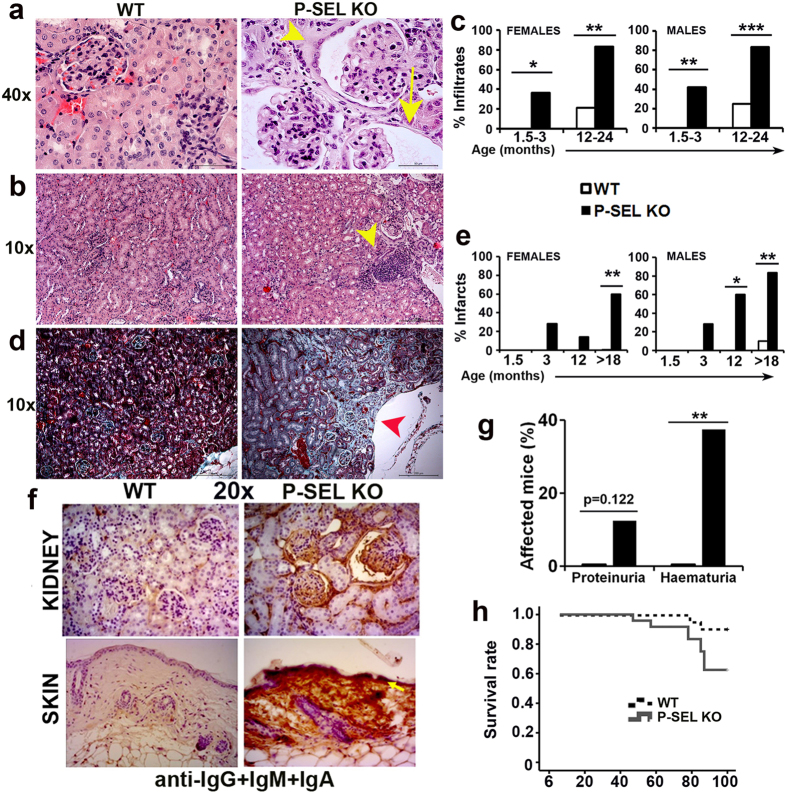
Kidney alterations and deposits of immune complexes in skin and kidneys of P-Sel−/− mice.(a) Representative photomicrographs (40×) of H&E-stained kidney glomeruli of WT and P-Sel−/− mice. Yellow arrow denotes a dilated Bowman’s space. Yellow arrowhead denotes a tubularized glomerulus. (b) Photomicrographs (10×) of kidney sections showing an immune infiltrate (yellow arrowhead) in P-Sel−/− mice. (c) Prevalence of immune infiltration in WT and P-Sel−/− mice (n = 8–10 mice per group). (d) Masson’s trichrome-stained kidney sections of WT and P-Sel−/− mice (10×), showing healthy and infarcted tissue (red arrowhead), respectively. (e) Prevalence of renal infarcts in WT and P-Sel−/− mice (n = 8–10 mice per group). (f) Representative photomicrographs of anti-IgM+ IgA+ IgG-stained kidney (upper panels) and skin (lower panels) sections (20×). n = 4–5 mice per group. Yellow arrow points to the dermoepidermal junction. (g) Frequency of proteinuria and hematuria in >12-month-old WT and P-Sel−/− mice (n = 14–16 mice per group). (h) Kaplan-Meier survival curves for WT and P-Sel−/− mice (n = 20 WT and 23 P-Sel−/− mice); p = 0.033 by Mantel-Cox test. (c,e,g) *p < 0.05; **p < 0.01; ***p < 0.005 by Chi-square test.